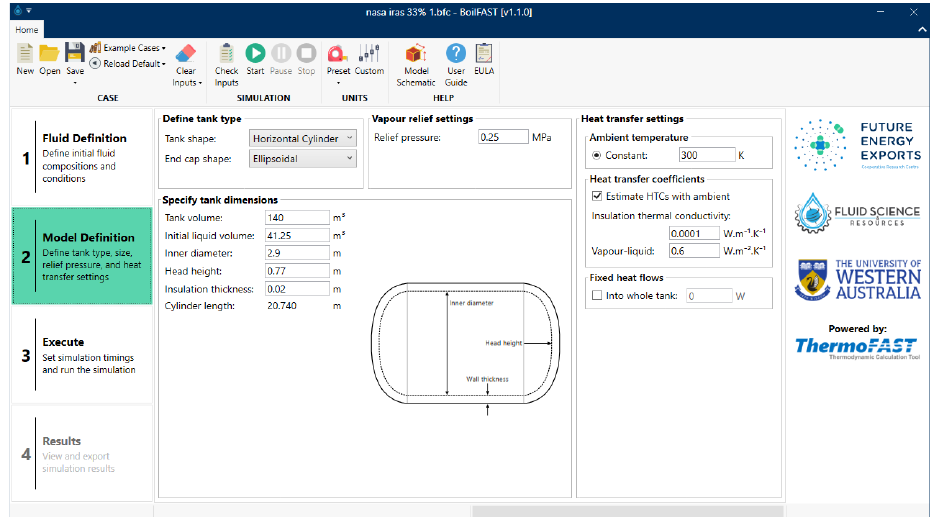
Figure 1. The BoilFAST Graphical User Interface (GUI), which is used to set up and run simulations using the SHV